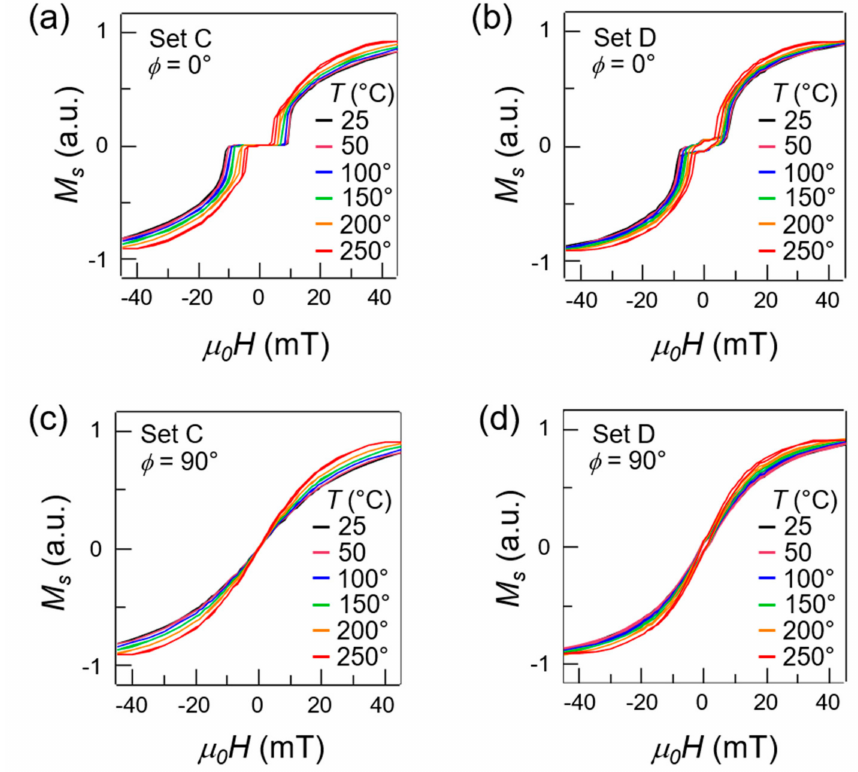
Figure 3. ( a , b ) Hysteresis loops of set C and set D along the easy-axis ( φ = 0 ◦ ) measured as a function of temperature (color-coded) ranging from 25 ◦ C to 250 ◦ C; ( c , d ) Hysteresis loops of set C and set D along the hard-axis ( φ = 90 ◦ ) measured as a function of temperature (color-coded) ranging from 25 ◦ C to 250 ◦